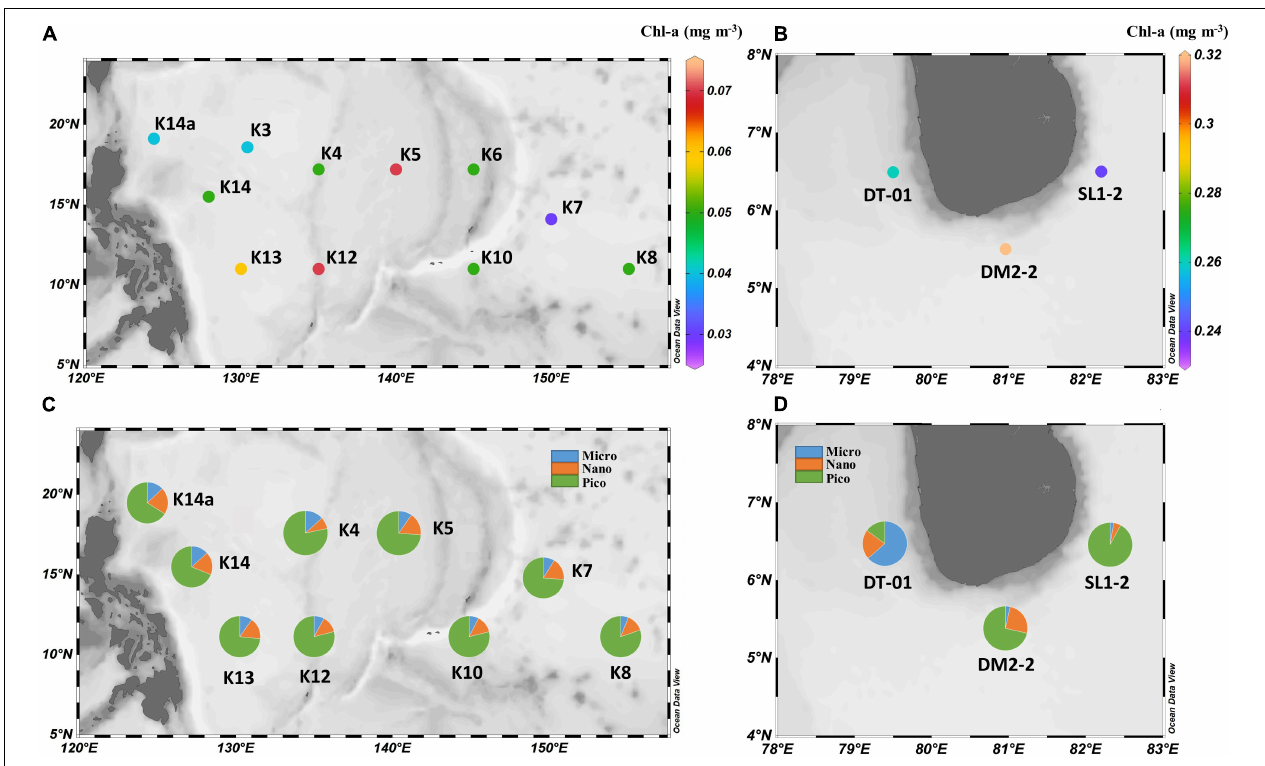
FIGURE 2 | (A,B) Plots of measured Chlorophyll-a (Chl-a) concentration from the surface at each station. (C,D) Plots of surface microphytoplankton ( > 10 µ m), nanophytoplankton (3–10 µ m), and picophytoplankton (0.7–3 µ m) community fraction at each